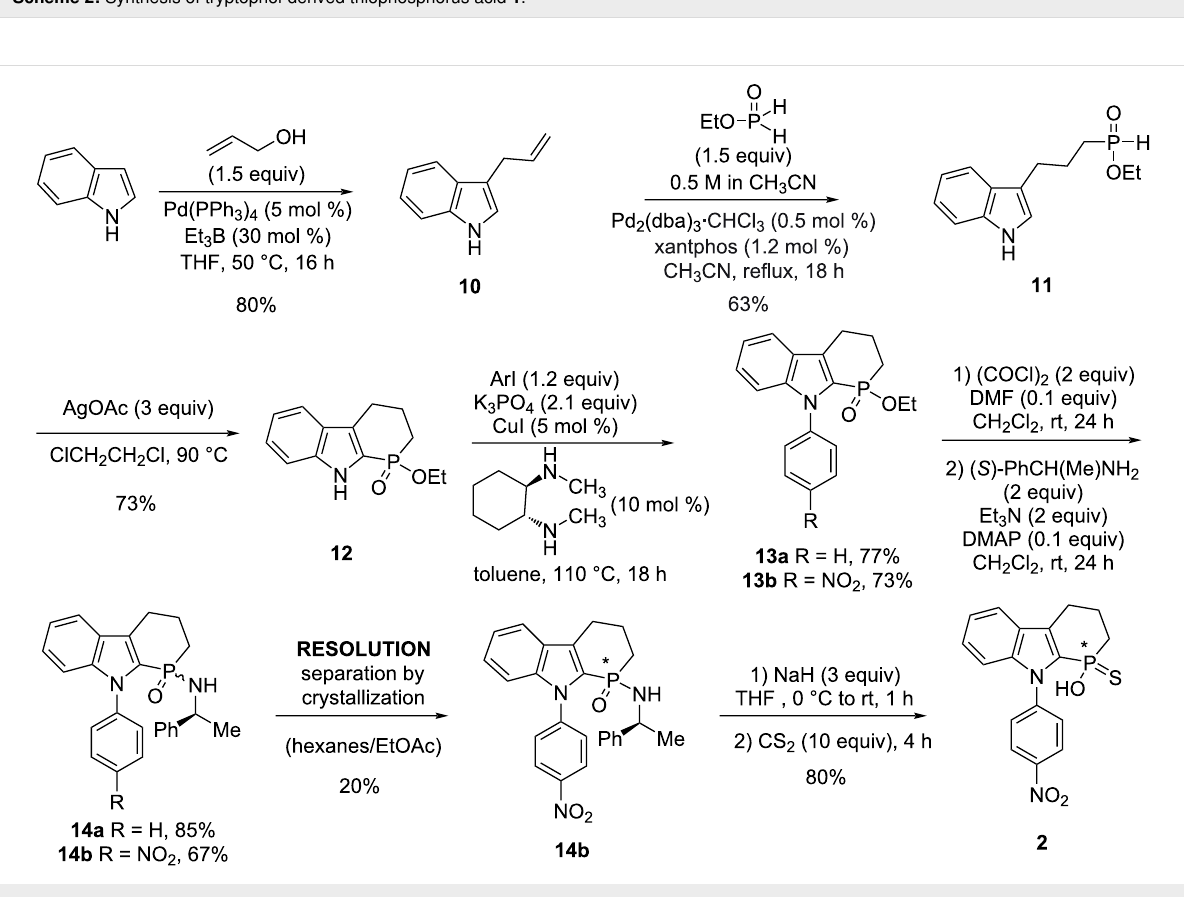
Scheme 3: Synthesis of indole-derived thiophosphorus acid 2